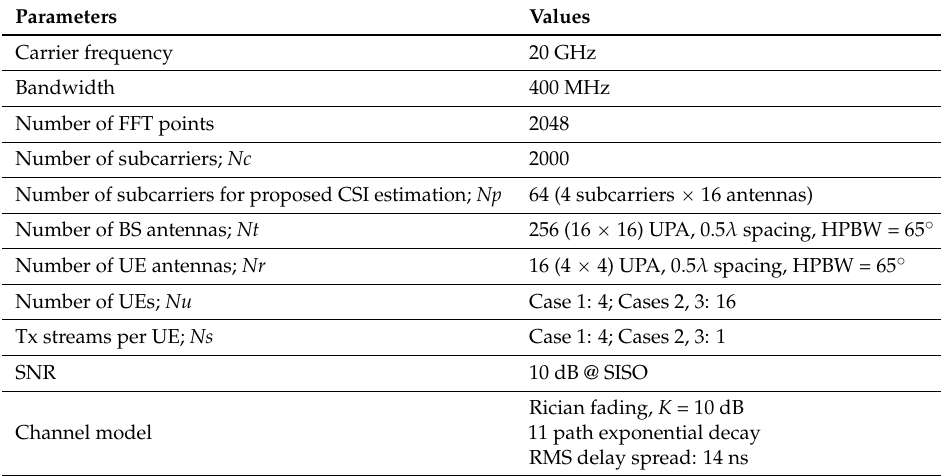
Table 2. Simulation